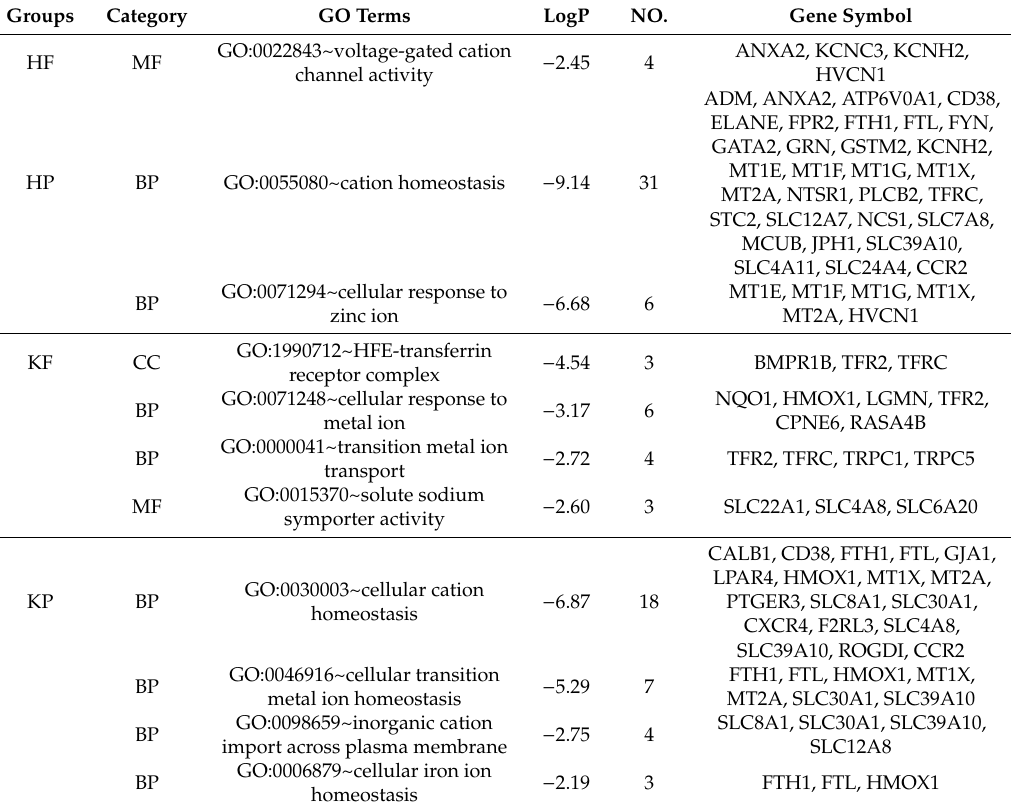
Table 2. GO terms of metal ion metabolisms in KG1a and HL60 exposed to FeNPs or PBNPs (Top 20, p <